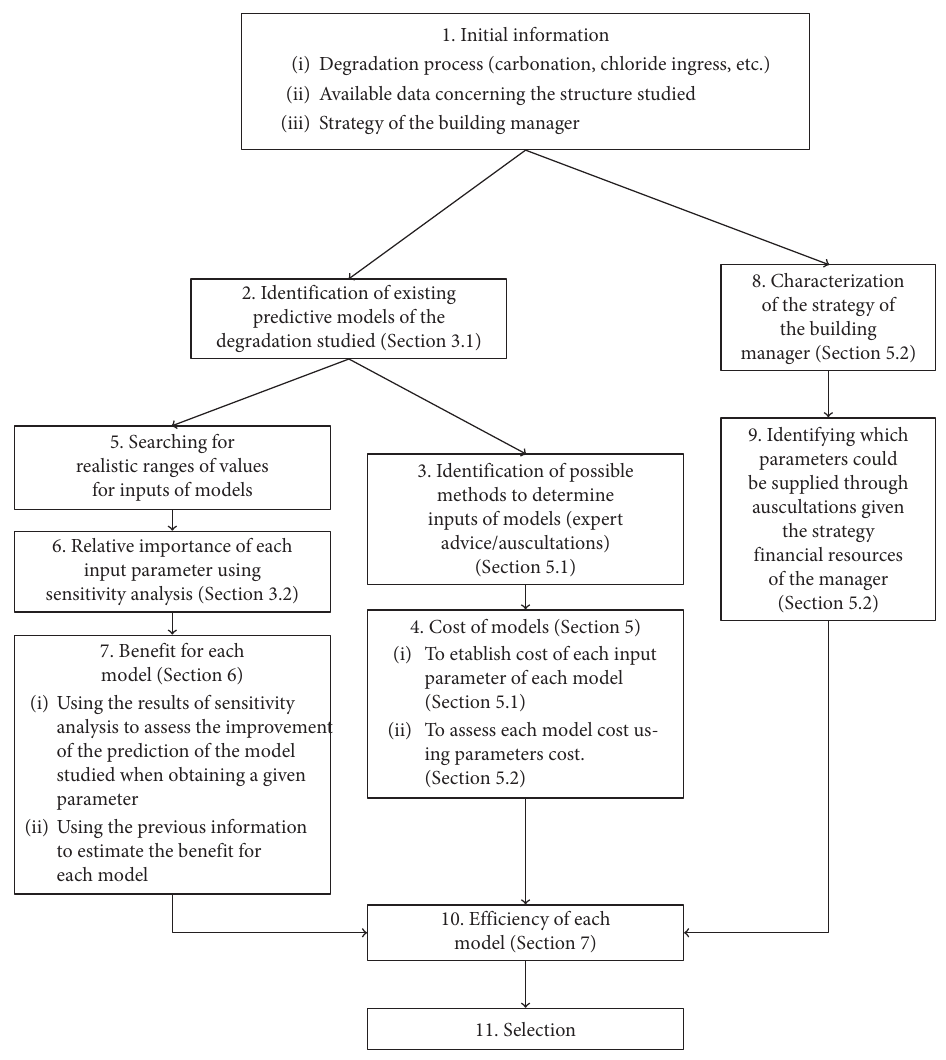
Figure 1: Flowchart of the method.